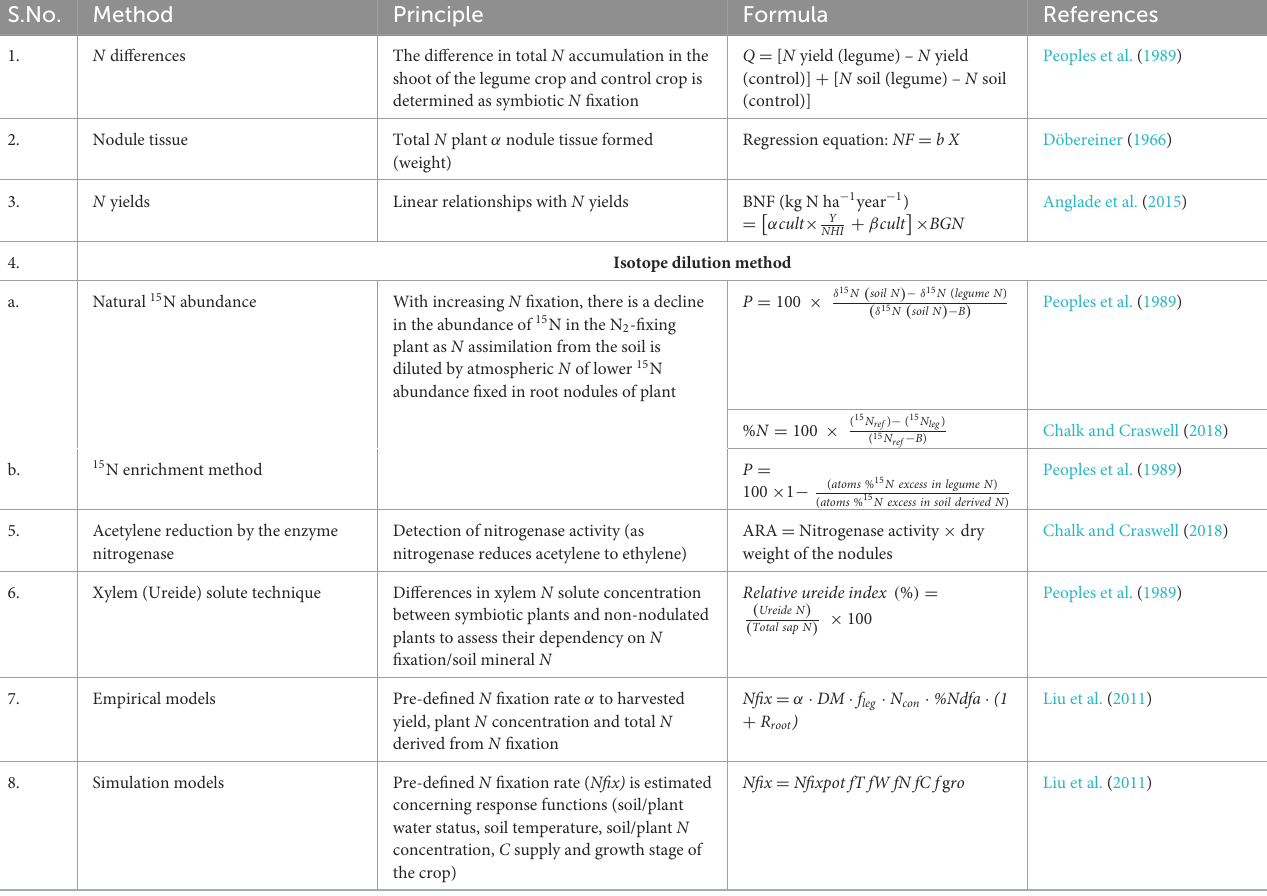
TABLE 10 Different methodologies and principles to assess biological N -fixation.